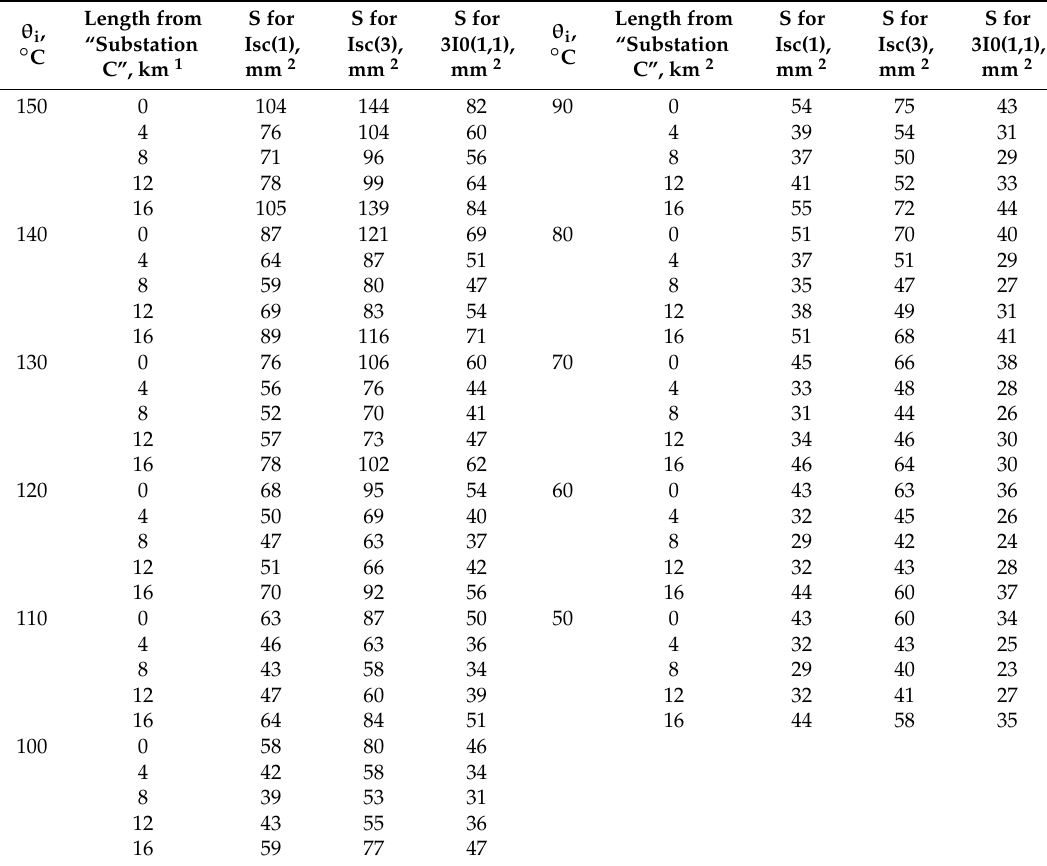
Table 2. Calculated minimum required cross-sectional area of conductor for “OHL No.2” based on three estimated short-circuit currents.